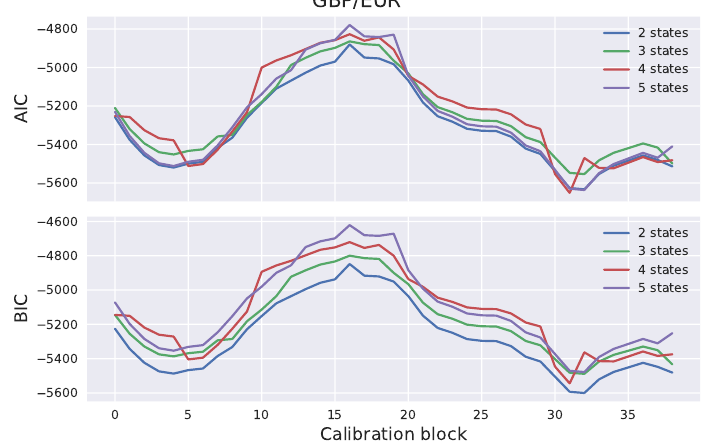
Figure 4. AIC and BIC for HMMs calibrated using GBP/EUR time-series.